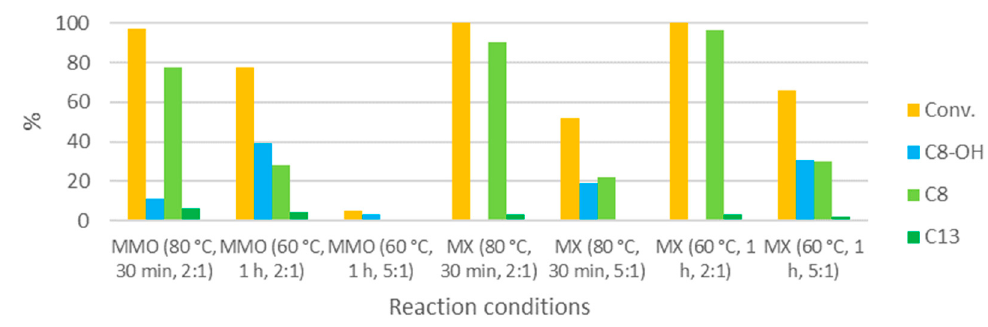
Figure 10. Performances of the various catalysts at lower temperatures (0.21 M).